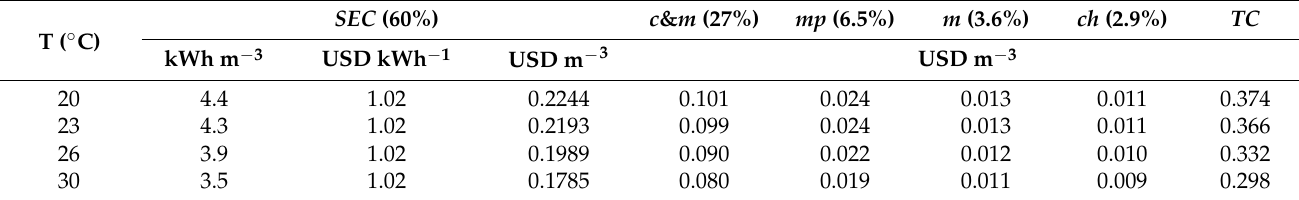
Table 3. Desalinated water